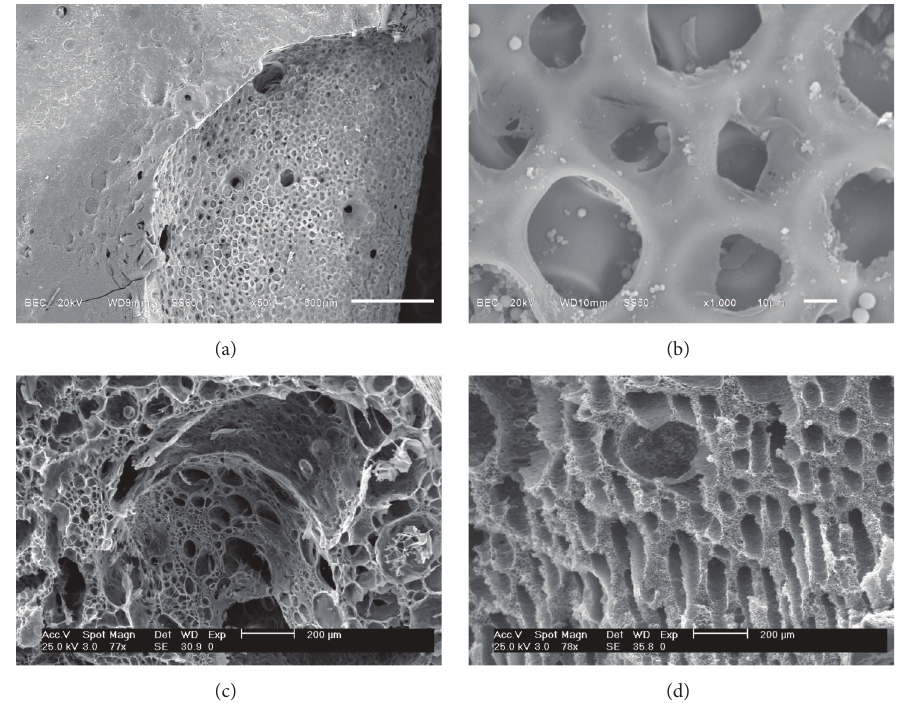
Figure 11: Sequence of scanning electron microscope images for different polymeric